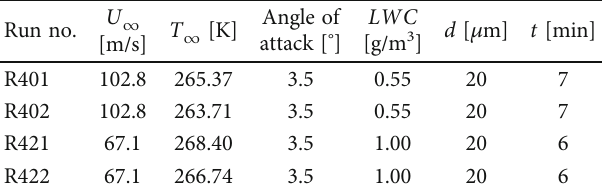
Table 1: Boundary conditions for icing simulations. Run